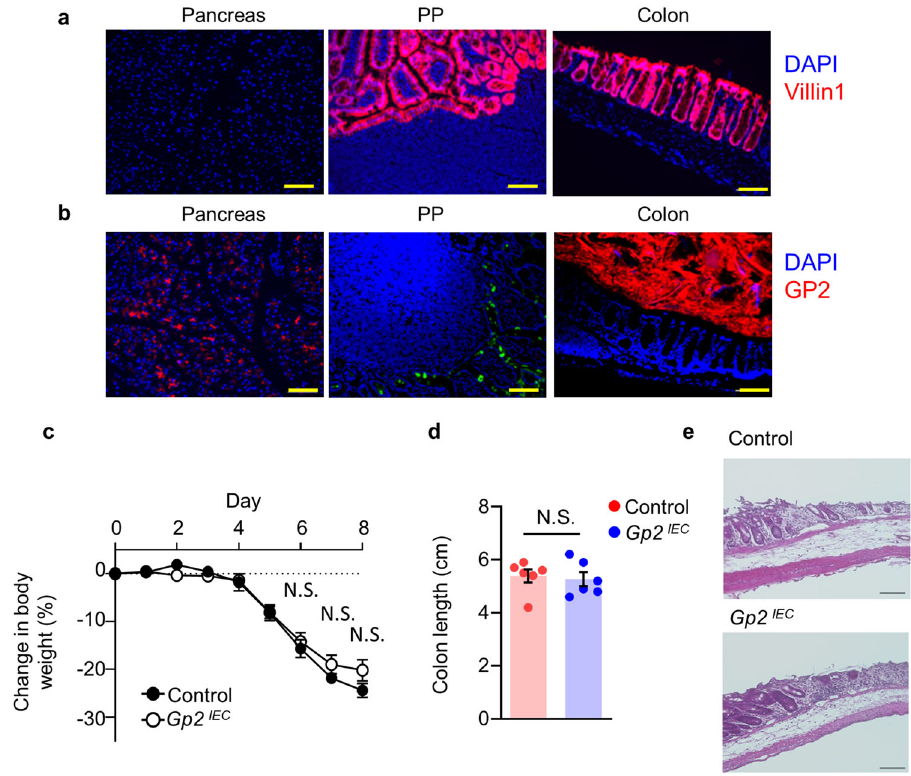
Fig. 5 DSS-induced acute colitis in mice lacking GP2 in gut-associated lymphoid tissue. a VIL1 expression in pancreas, Peyer ’ s patch (PP), and colon of Vil1-cre-tdTomato mice were shown. b GP2 (red) distribution in Vil1-cre-Gp2 fl ox/ fl ox ( GP2 IEC ) mice were shown. Green color indicates UEA-1 in PP. Representative data of three independent experiments are shown. Scale bars, 100 μ m. c Body weight change after induction of acute colitis in GP2 IEC and control (WT Gp2 fl ox/ fl ox ) mice ( n = 7 /group). N.S. indicates not signi fi cant (two-tailed unpaired t -test). Data are presented as mean values ± SEM. d Colon length in GP2 IEC and control mice were shown ( n = 7 /group). N.S. indicates not signi fi cant (two-tailed unpaired t -test). Data are presented as mean values ± SEM. e Hematoxylin and eosin staining of colon tissues were shown. Scale bars, 100 μ m. Data are representative of three independent experiments. Source data are provided as a Source Data fi